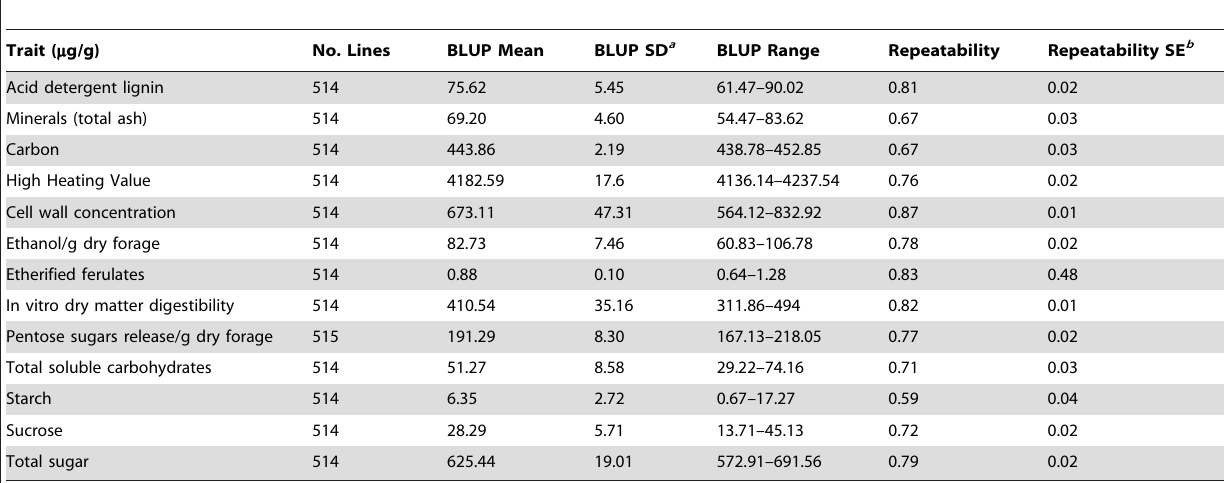
Table 3. Means and ranges for best linear unbiased predictors (BLUPs) of 13 quality traits evaluated on a switchgrass association panel, and estimated repeatability on a clone-mean basis in two summer environments, in Ithaca, NY, across two years.